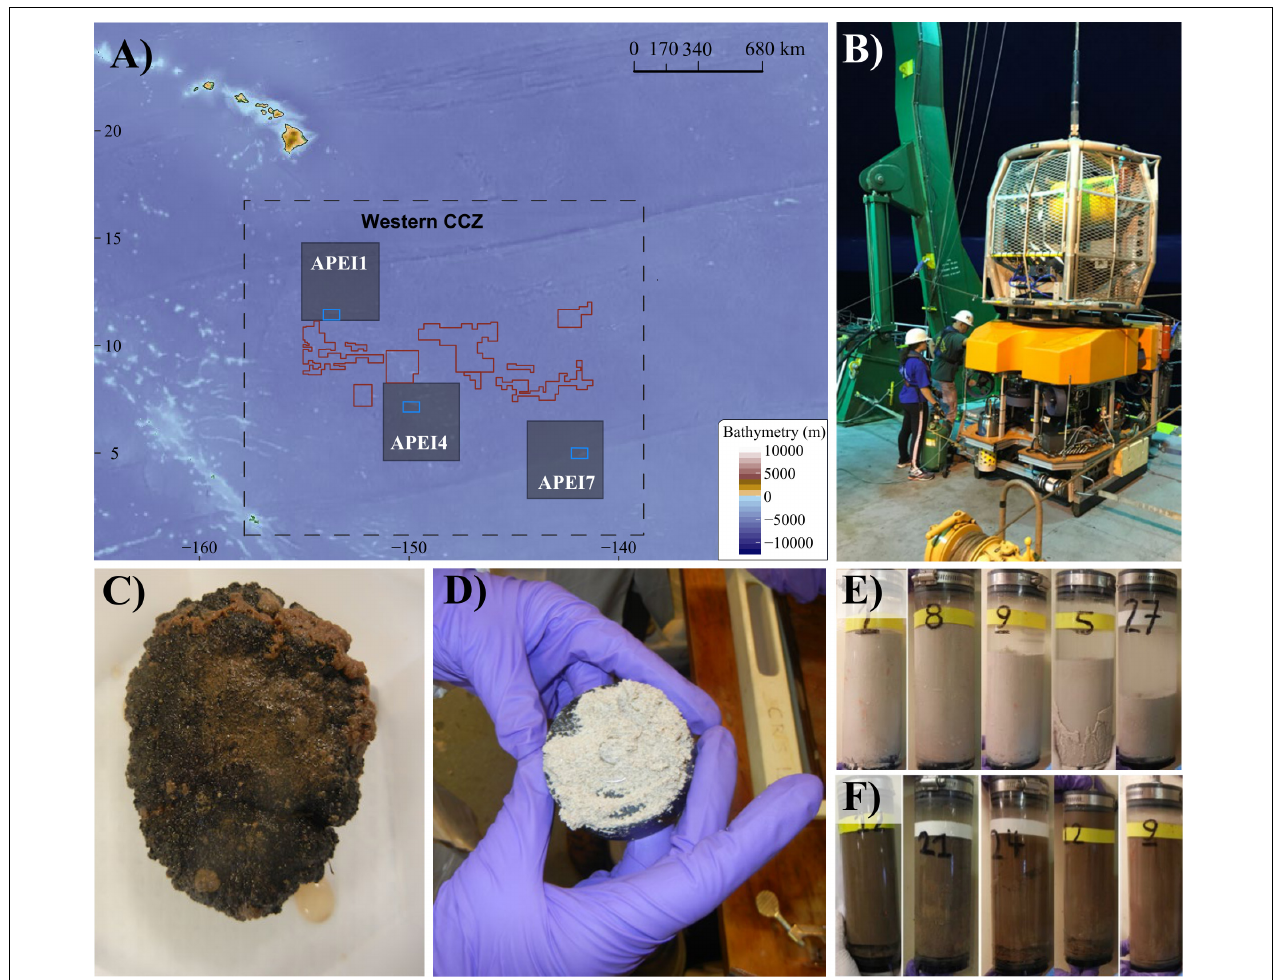
FIGURE 1 | Sampling sites, sampling tools (ROV Lu’ukai), and substrates collected. (A) Map of the study areas within the western Clarion Clipperton Zone (Western CCZ), with the locations of Areas of Particular Environmental Interest (APEIs 1, 4, 7) indicated (gray squares). Sampling regions within each APEI are marked by blue rectangles. Exploration mining contractor (red outline) areas within the western CCZ are also shown. See Supplementary Figure S1 for greater detail on the sampling sites. (B) Remotely operated vehicle (ROV) Lu’ukai, used for collection of sediment and polymetallic nodules. (C) Example of a polymetallic nodule. (D) Example of seamount sediment texture, largely made up of foraminiferal tests. A thin slab of sediment is shown on top of a black rubber plate (push core base). (E) Seamount sediment cores. (F) Abyssal plain sediment cores.